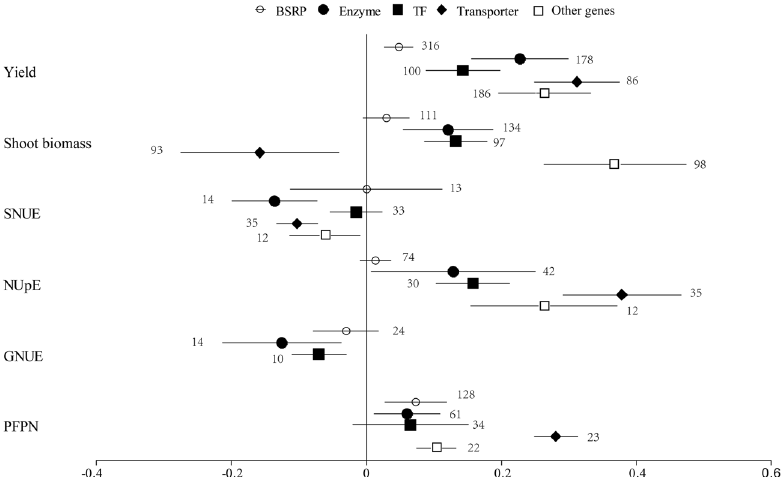
Figure 2. Effect sizes of yield, shoot biomass, shoot N utilization efficiency (SNUE), N uptake efficiency (NUpE), grain N utilization efficiency (GNUE) and partial factor productivity of N (PFPN) classified by gene categories. Only datasets with more than 10 observations were analyzed. BSRP: biotic stress related protein. TF: transcription factors. Error bars represent 95% bootstrapped confidence intervals (CIs). The effects of genetic transformation were considered significant if the 95% CIr of the effect size did not overlap with zero. The number of observations for each category are shown next to the error